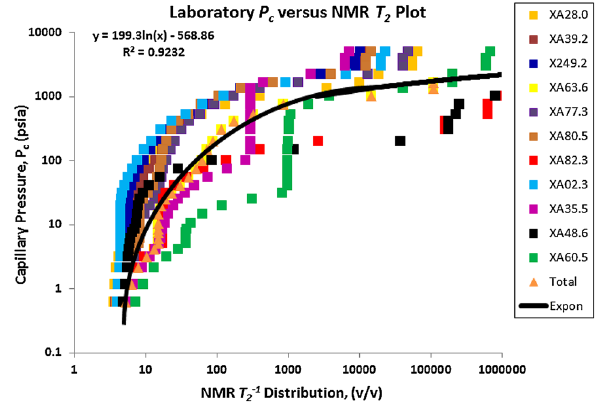
Fig. 9 Mercury injection capillary pressure curves versus NMR derived capillary pressures indicating poor correlation at pressures below the imposed cut-offs for the entry pressures and transition